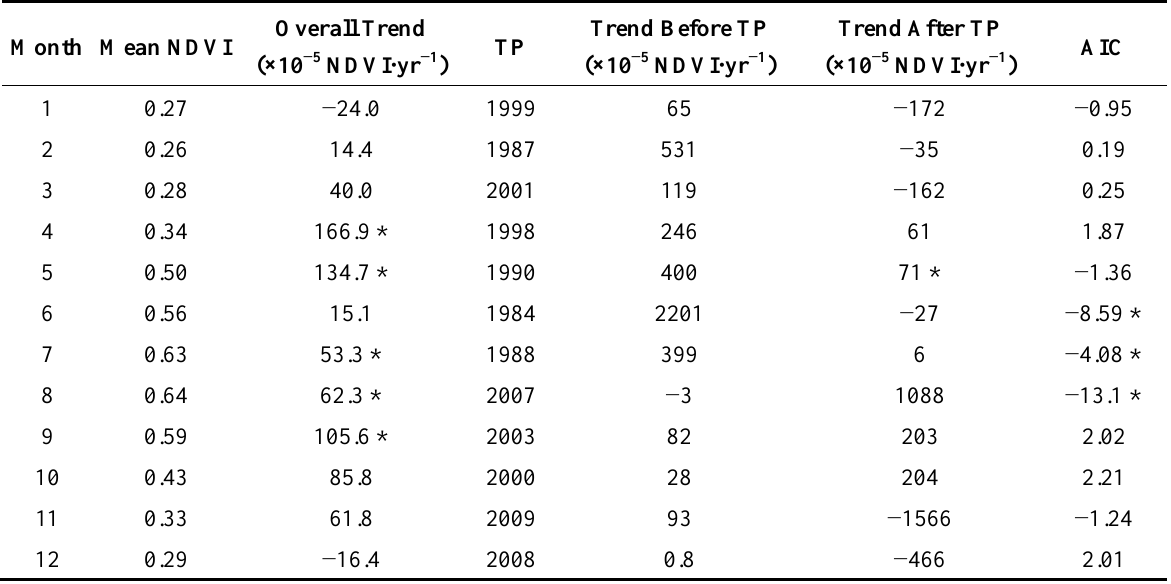
Table 1. Trends and TPs of NDVI for entire study area, in each month from 1982 to